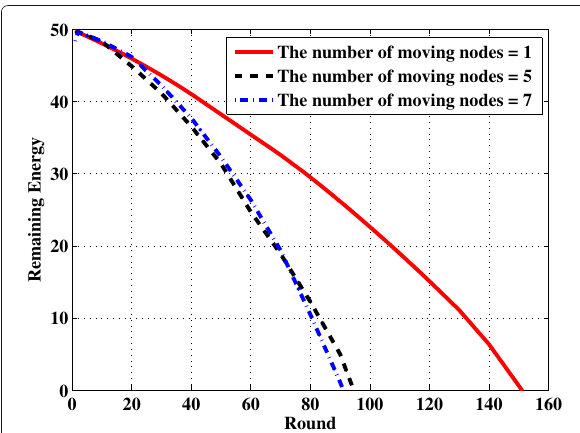
Fig. 4 The relation between remaining energy and the number of rounds